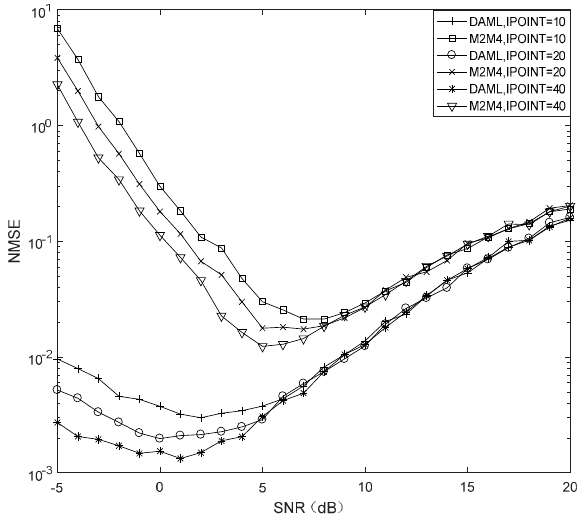
Figure 5. NMSE comparison of DA ML and M 2 M 4 in different IPOINT.